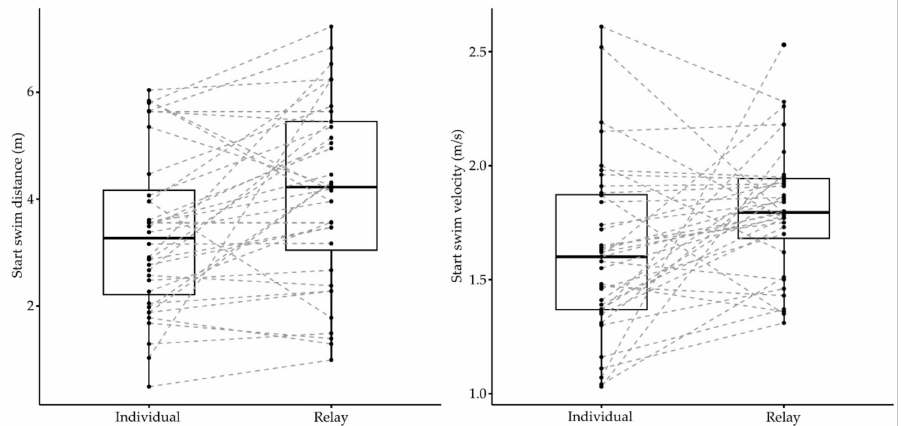
Figure 3. Individual and group variation in the swim start phase between individual and relay events of the LEN European Junior Swimming